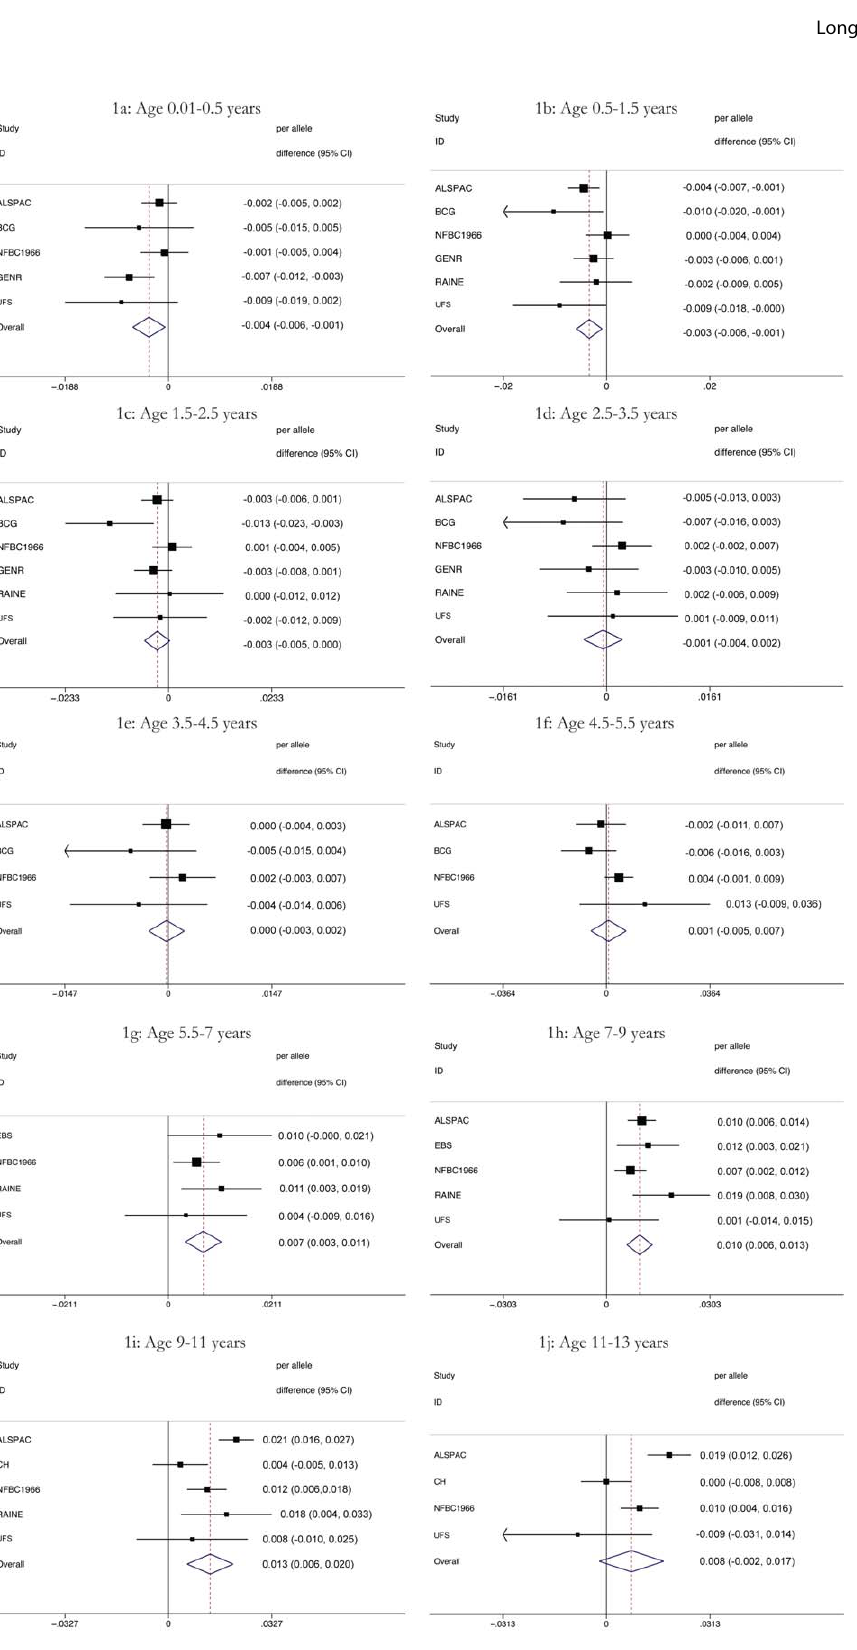
PLoS Genetics | www.plosgenetics.org